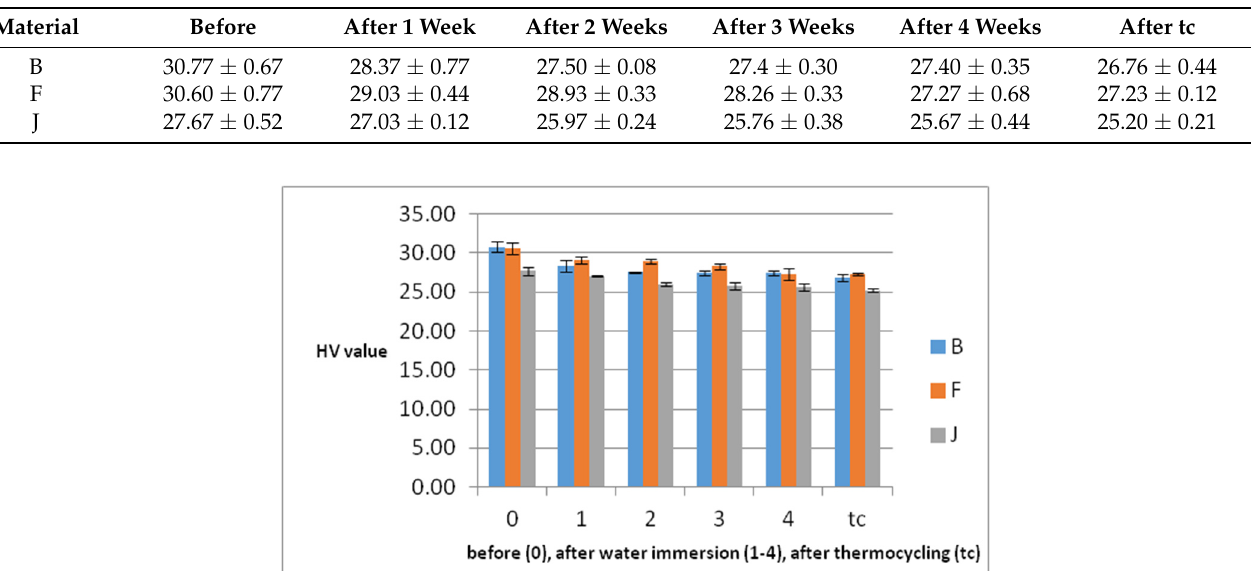
Figure 5. Nanoroughness values of the samples before each week of water immersion(0), after (1–4), and after thermocycling: ( a ) Sa values and ( b ) Sy values. Table 3. Mean hardness values of the samples before water immersion, during the 4 weeks, and after tc with SD.